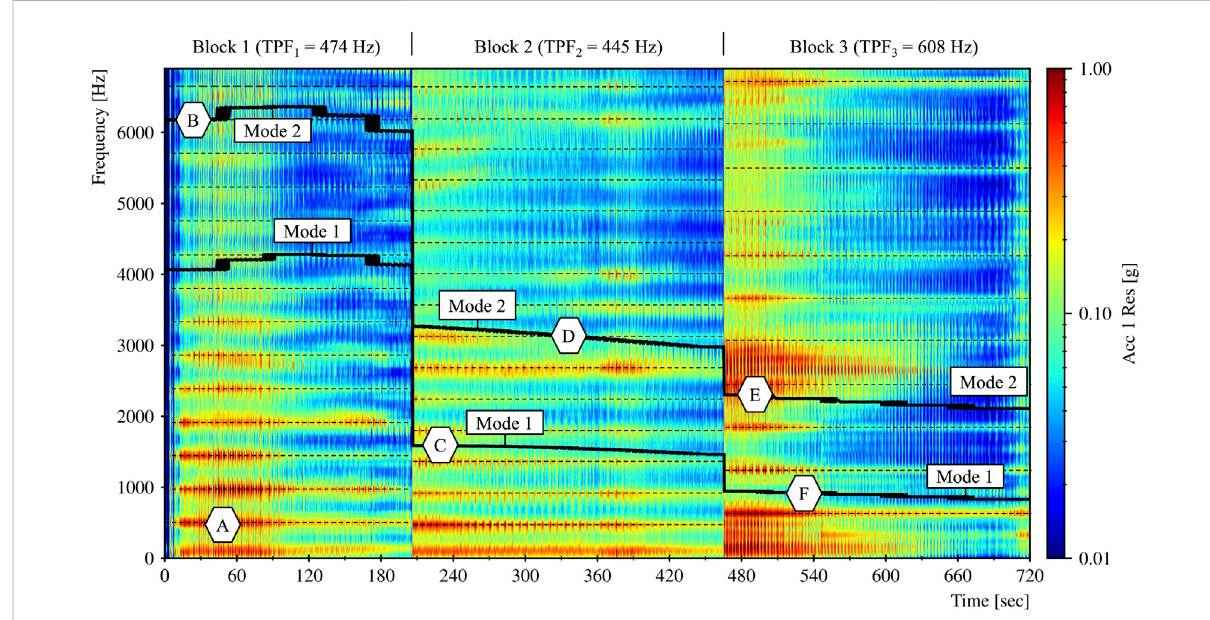
FIGURE 14 Spectrogram of the fi nishing operations from block 1 to 3 with changing eigenfrequency related to mode 1 and